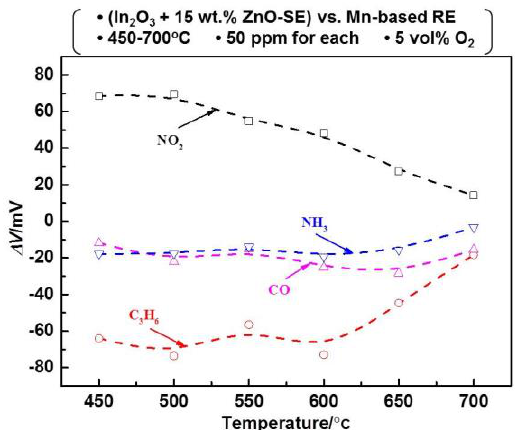
Figure 5. Response patterns of the sensor to the examined gases (50 ppm) at various operating temperatures.